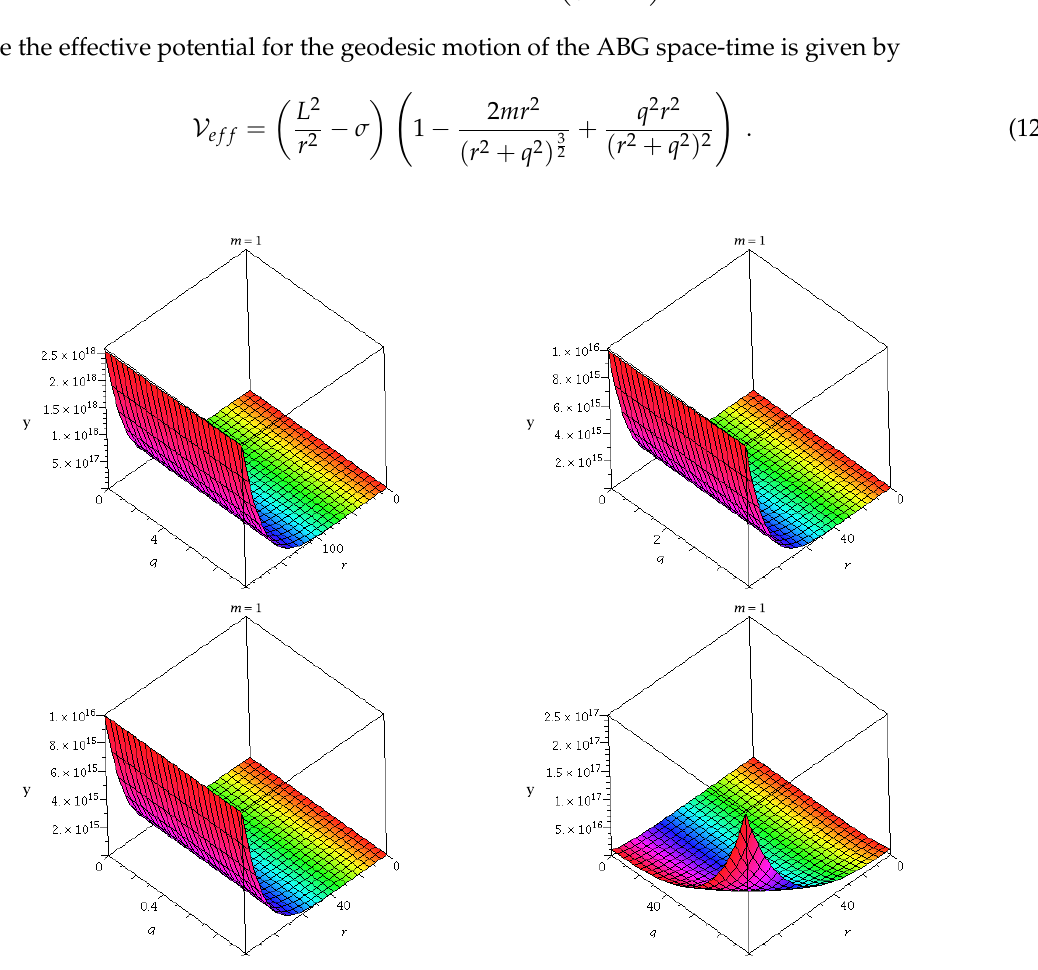
Figure 2. The figure depicts the variation of y = r 8 + ( 6 q 2 − 4 m 2 ) r 6 + ( 11 q 4 − 4 m 2 q 2 ) r 4 + 6 q 6 r 2 + q 8 with r for different values of q